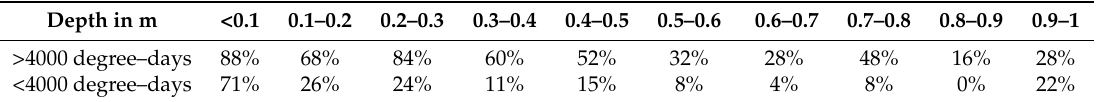
Table 3. Percentage of significant negative parameter coefficients ( p < 0.05) resulting from the ANCOVA analysis for ground temperatures (depths of 0–1 m) divided into sites with freezing degree days above and below 4000